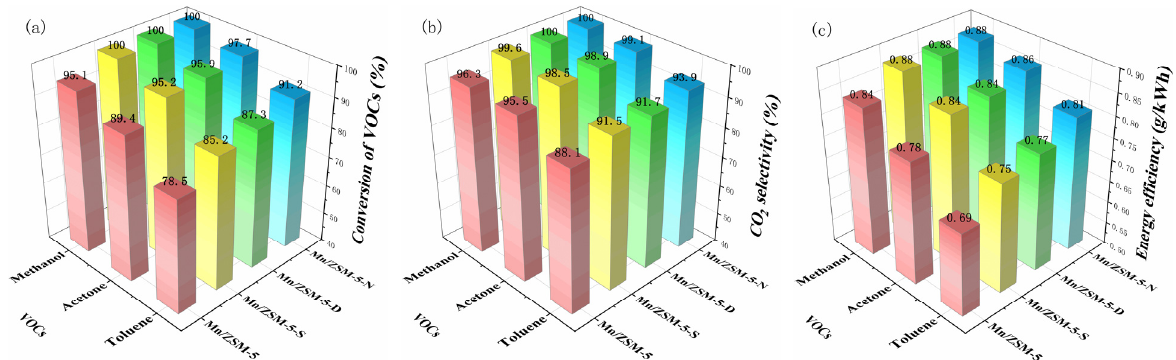
Figure 1. ( a ) Conversion, ( b ) CO 2 selectivity, and ( c ) energy efficiency of various VOCs on catalysts at the initial concentration of 2000 ppm and SIE of 9 kJ/L.